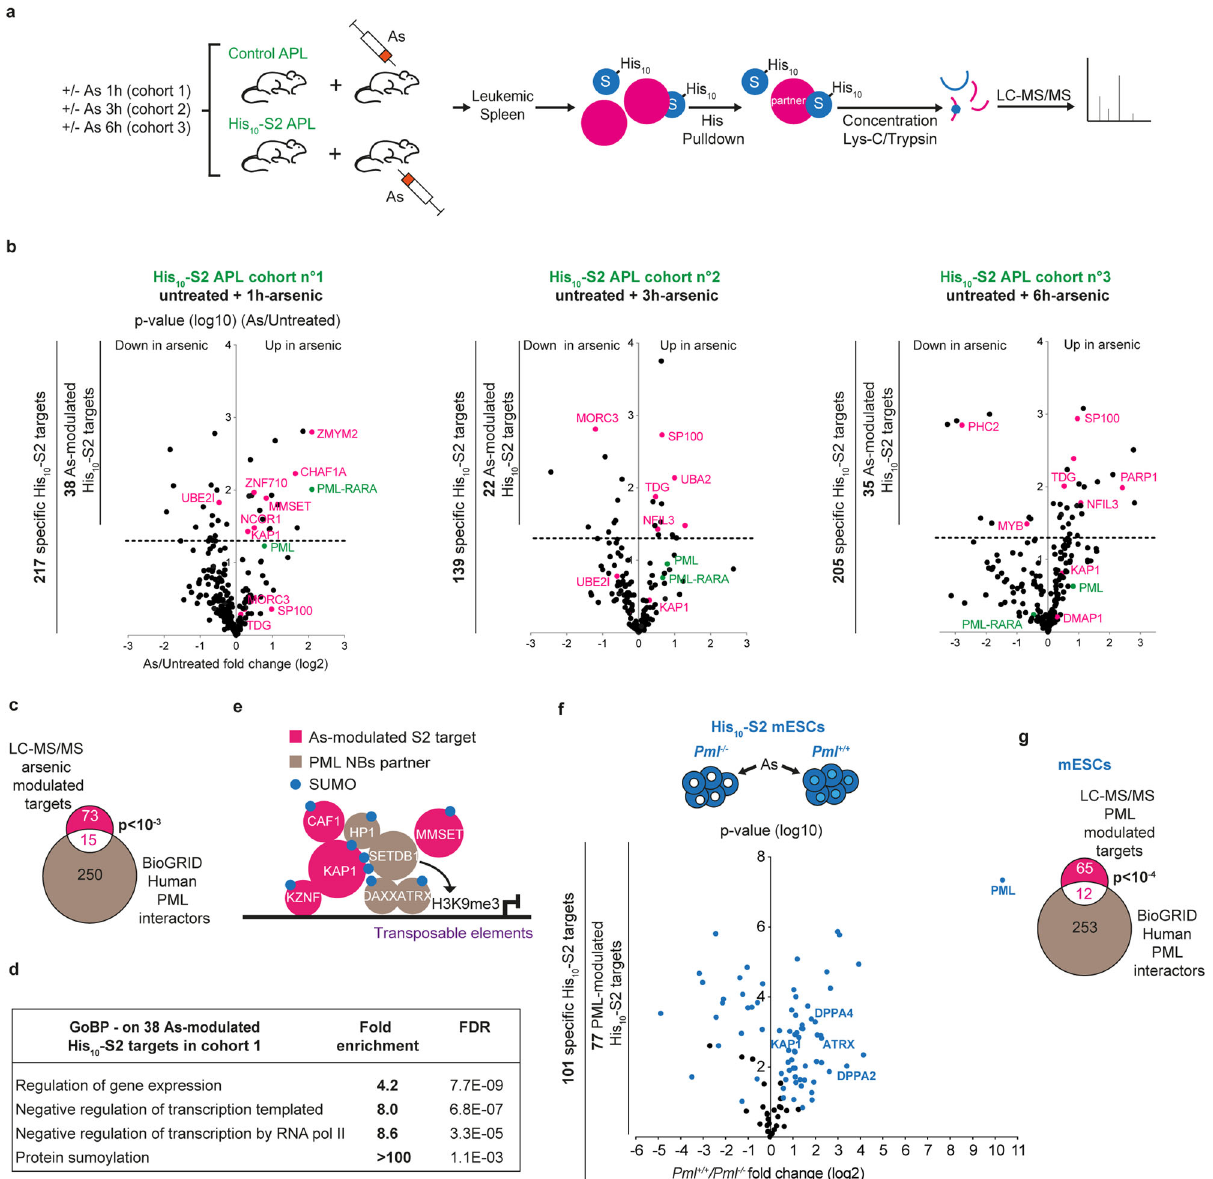
Fig.3|Identi fi cationoftheHis 10 -SUMO2targetsuponarsenic-inducedPMLNB reorganization in APL mice. a Experimental setup for differential SUMO- proteome analyses upon arsenic, based on large-scale PD of His 10 -S2 conjugates from three mouse cohorts, each containing 6 Ctrl and 6 His 10 -S2 APL mice treated ( n =3) or not with arsenic ( n =3), for the indicated time, followed by LC-MS/MS analyses. b Volcano plots showing proteins differentially sumoylated in arsenic- vs untreated His 10 -S2 APL mice for each cohort; label-free quanti fi cation (LFQ) fold changes; p -values,two-sided t -test;dashedlinerepresentsp-valuethreshold(0.05). Targets plotted when signi fi cantly enriched in His 10 -S2 vs Ctrl APL mice (Supple- mentary Data 1), numbers of identi fi ed proteins in each group are indicated (left bars). c Venn diagram showing proteins common to arsenic-modulated His 10 -S2 targets identi fi ed in ( b ) and previously reported PML partners in ref. 33 and